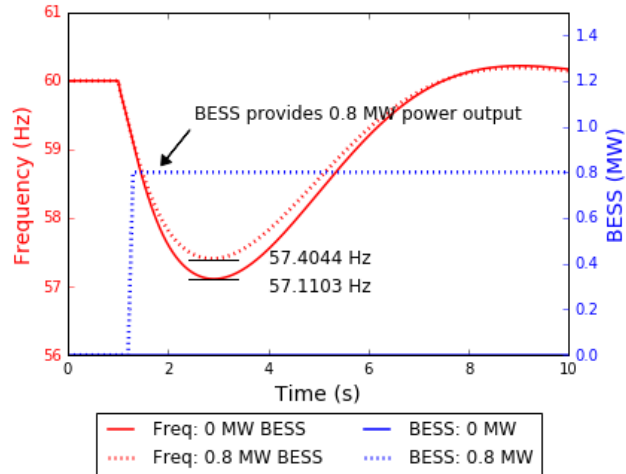
Figure 6. The contingency simulation with/without BESS power support. Table 1. The frequency support capability of BESS—case study.